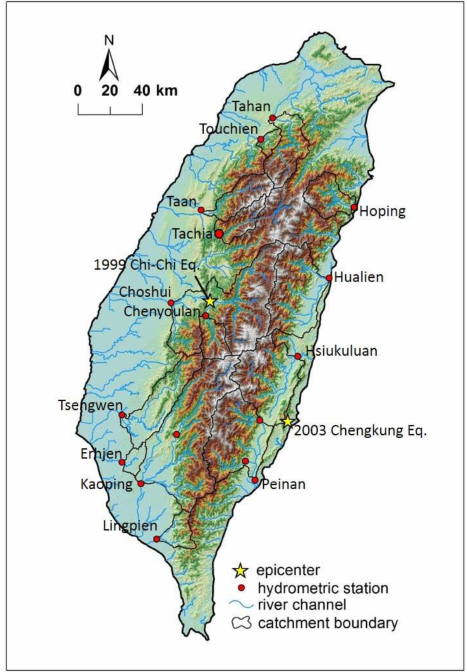
Figure 1. Distribution of river catchments and hydrometric stations. The star symbols represent the epicenters of the 1999 Chi-Chi earthquake and 2003 Chengkung